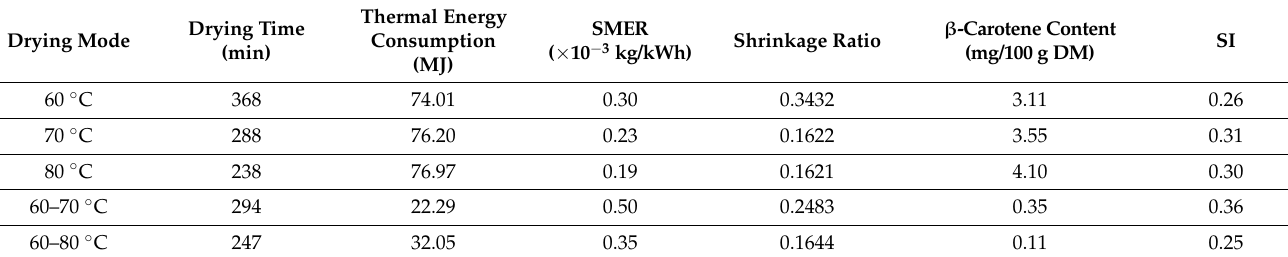
Table 3. Simulated results at the desired moisture content of 10%